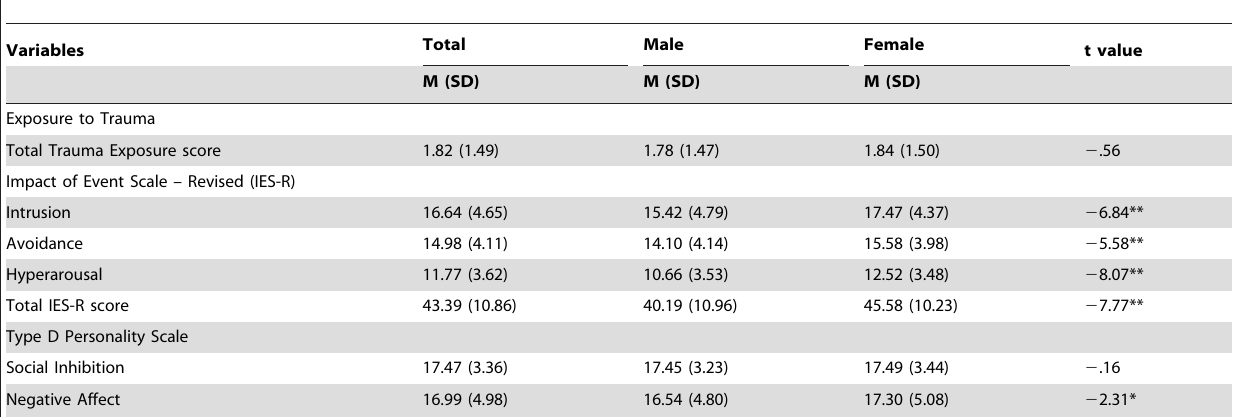
Table 2. Mean and standard deviation of IES-R scores and other psychological variables by gender.